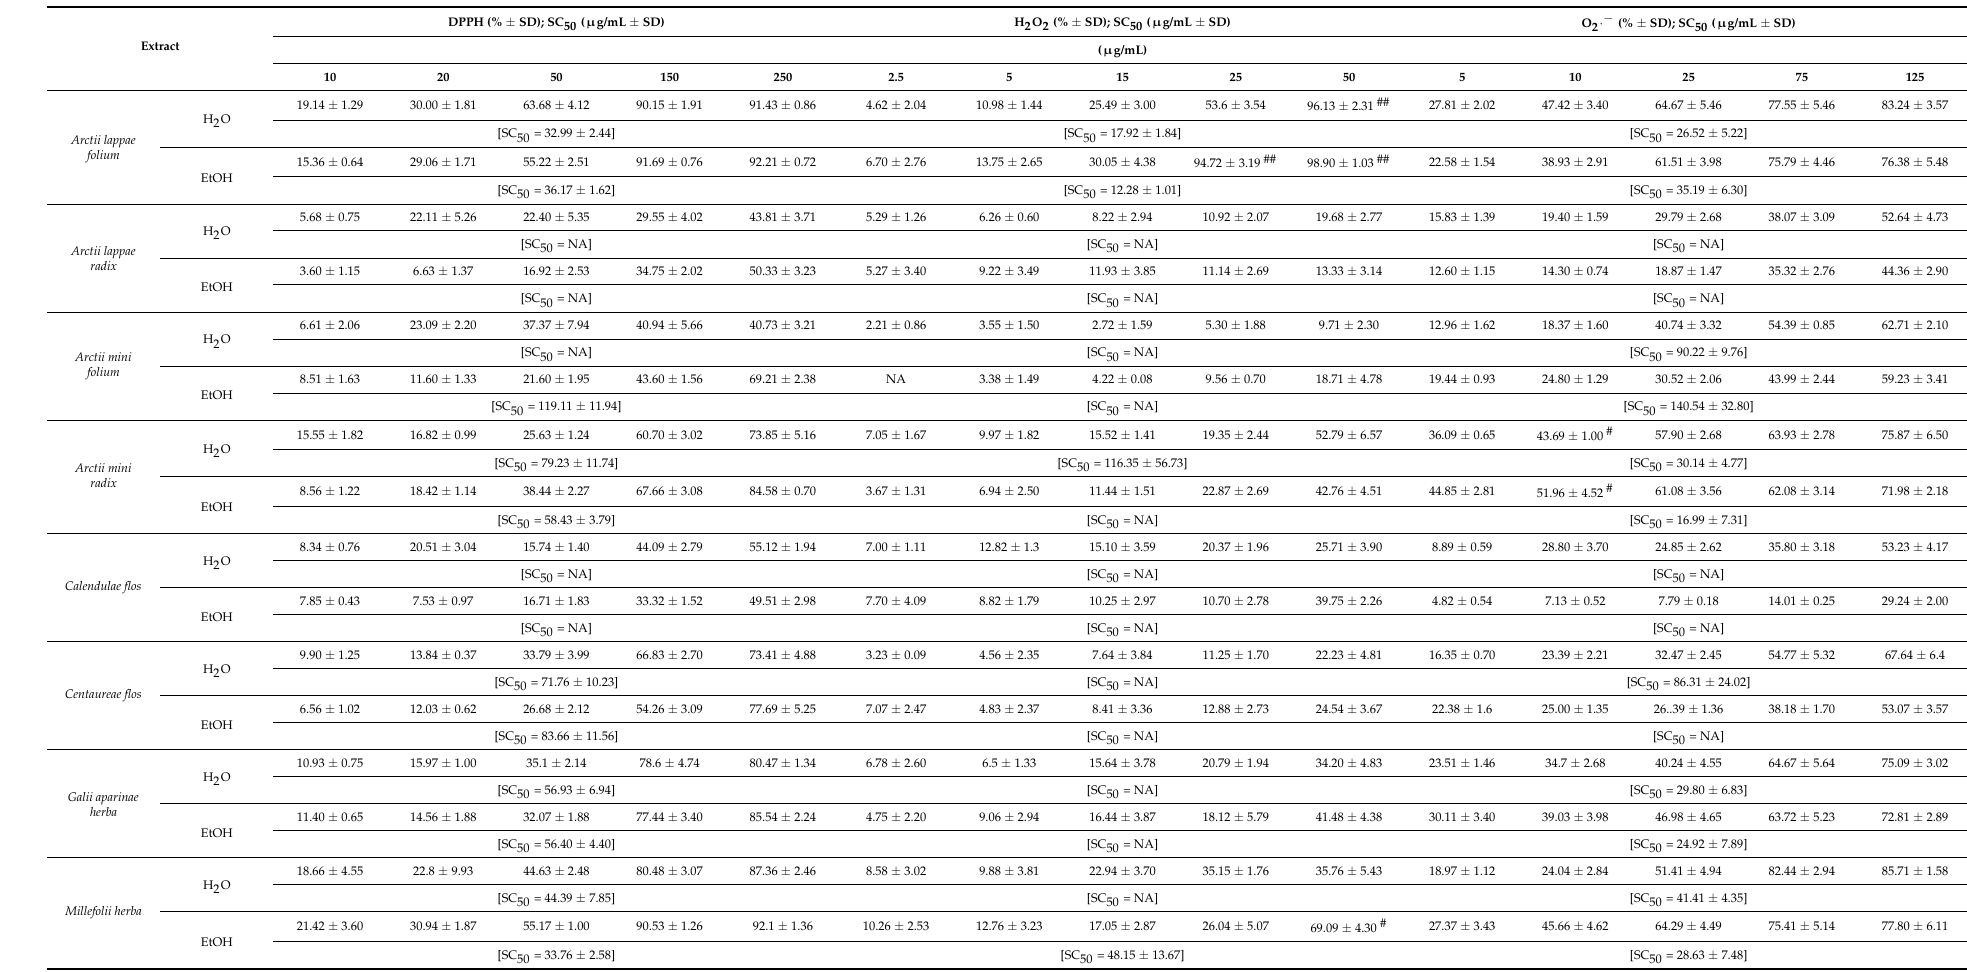
Table 2. Scavenging effects of the tested extracts on 2,2-diphenyl-1-picrylhydrazyl (DPPH), hydrogen peroxide (H 2 O 2 ), and superoxide anion radicals (O 2 •− ) generated by the OX/X system. NA denotes a SC 50 (substance/extract concentration eliciting 50% of the maximum radical scavenging) value higher than 150 µ g/mL. ## —the most active extract/extracts ( p < 0.001), # —extracts with higher activity than the others but weaker than the most active ones ( p <